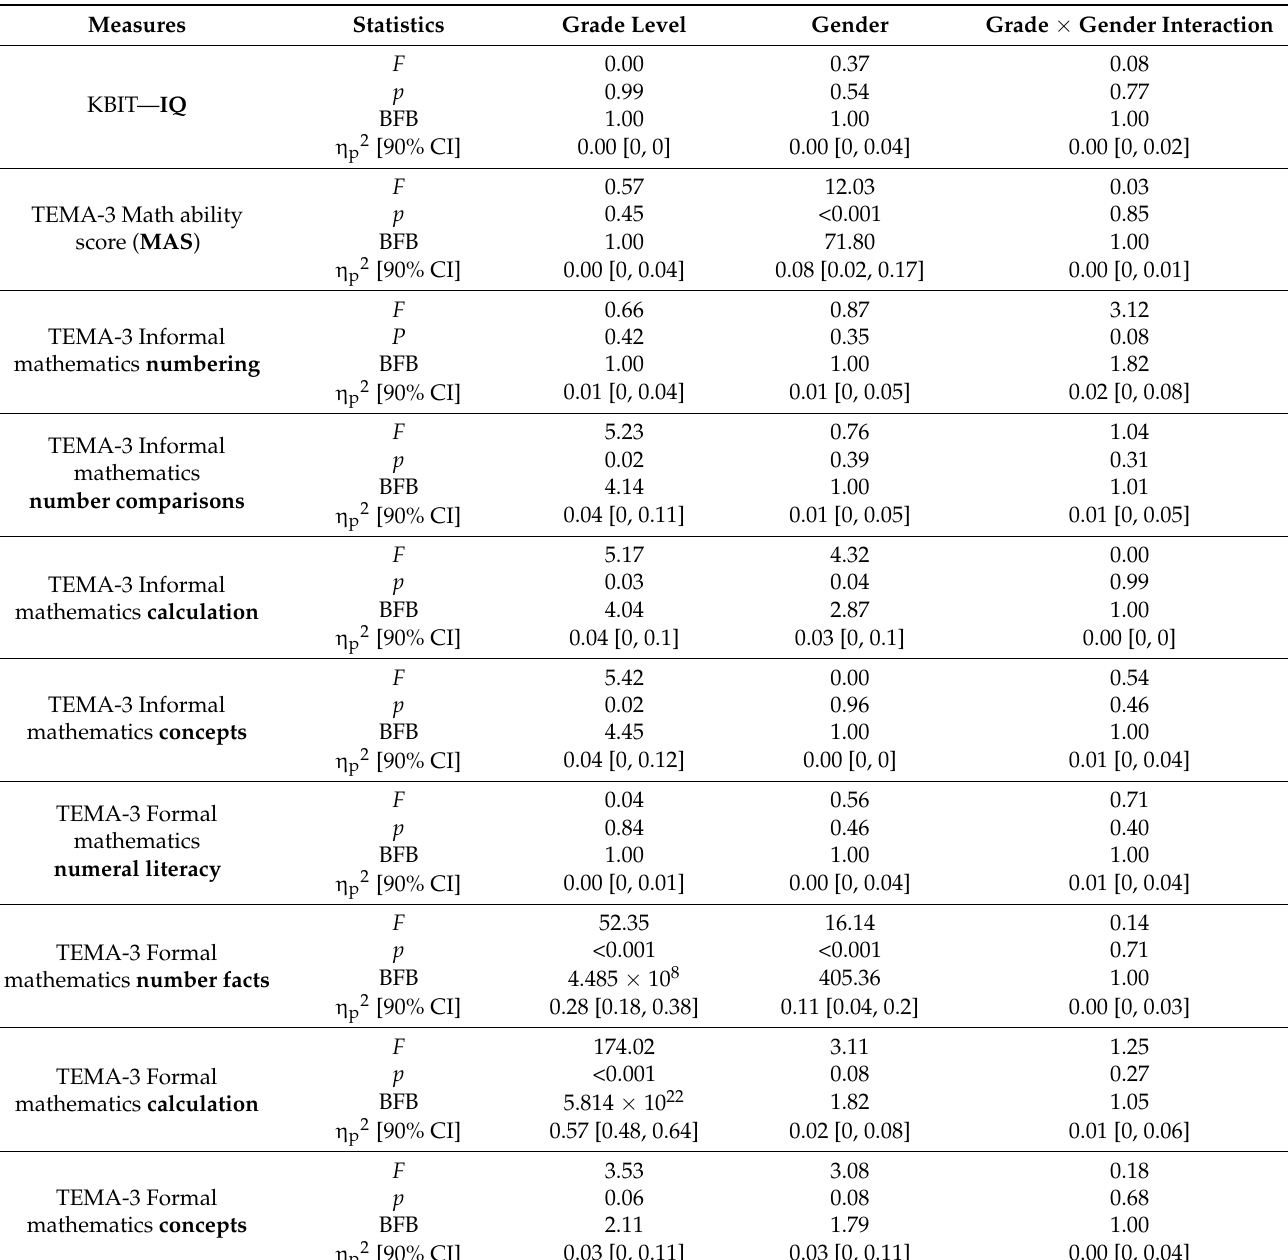
Table 3. Statistics for fixed effects (Grade Level and Gender) in univariate ANOVAs conducted on K-BIT and